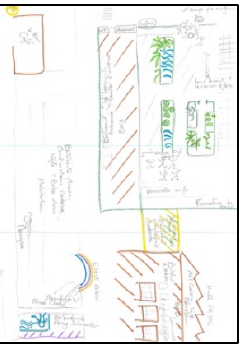
Figure 4. Example of landmarks